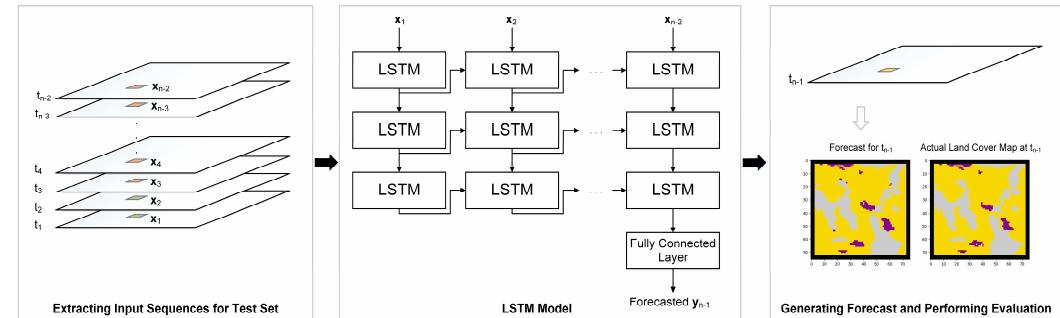
Figure 1. End-to-end methodology for generating and evaluating forecasted maps in each modeling